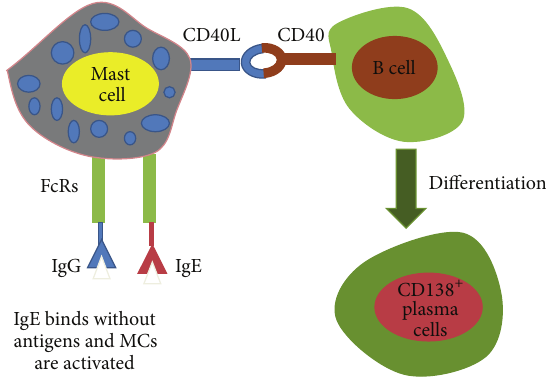
Figure 2: Direct cell interaction between mast cells and B